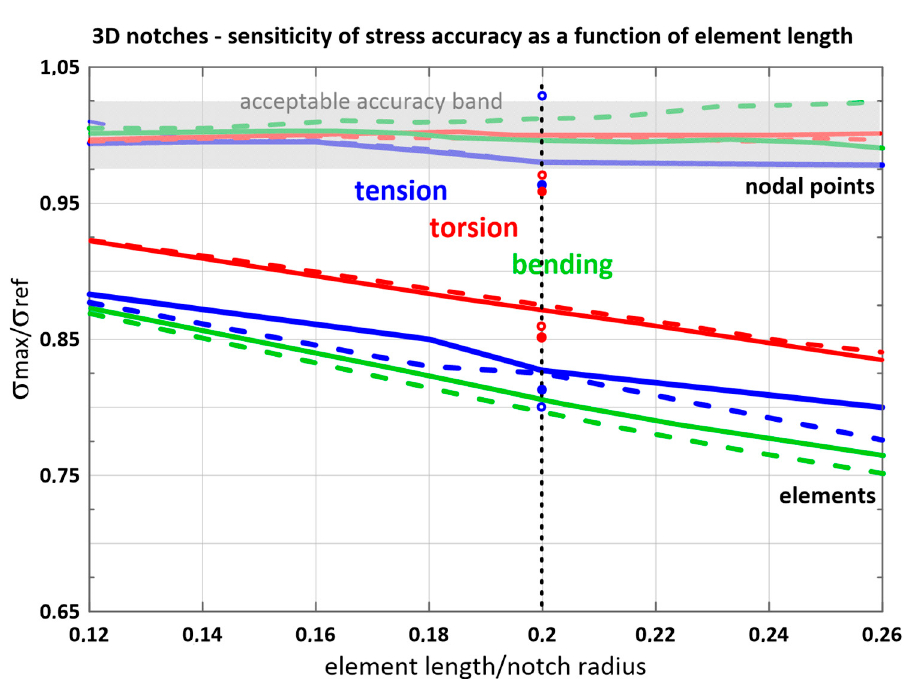
Figure 6. Analysis of the accuracy of notch root stress obtained by FEM simulation as a function of element mesh density for 3 selected cases of 3D notched components: solid lines—linear elements; dashed lines—quadratic elements.